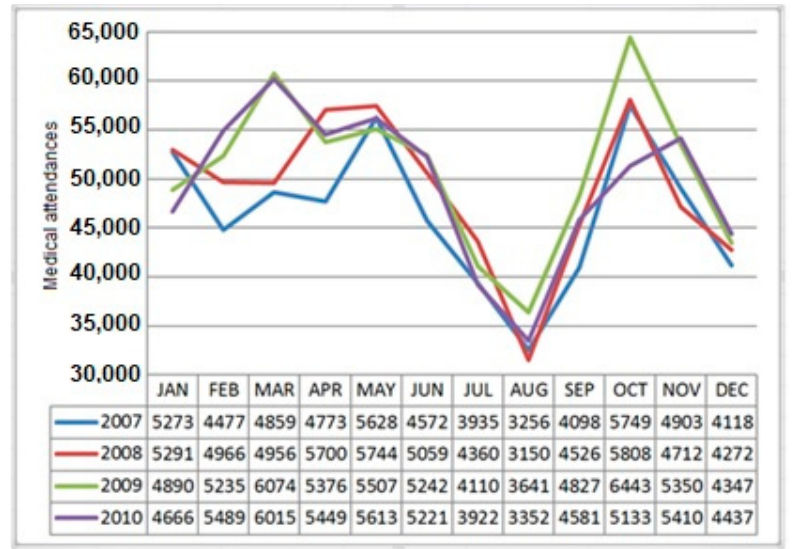
Figure 1. Distribution of medical attendances grouped by month from 2014 to 2017.